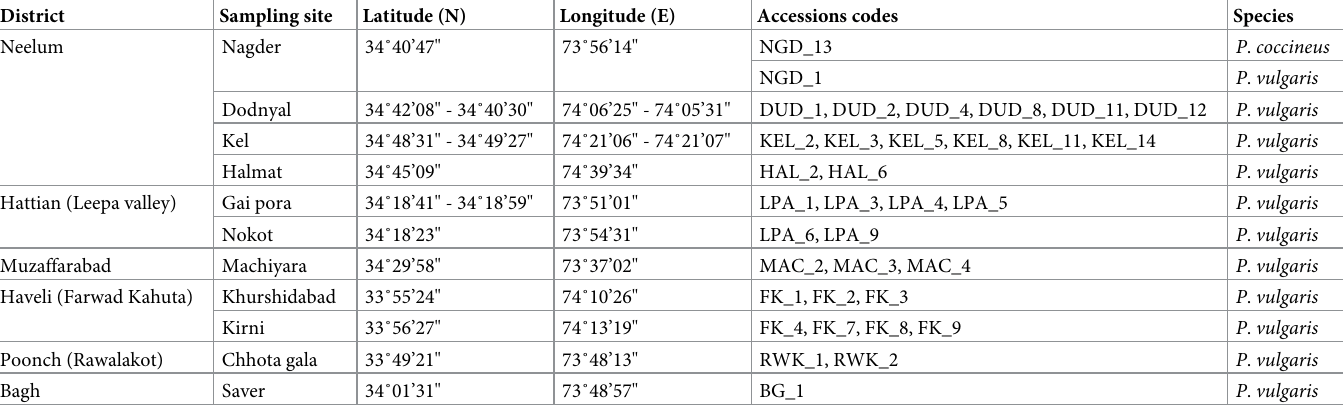
Table 1. Phaseolus vulgaris accessions and geographical coordinates of sampling sites in Azad Jammu and Kashmir, Pakistan.